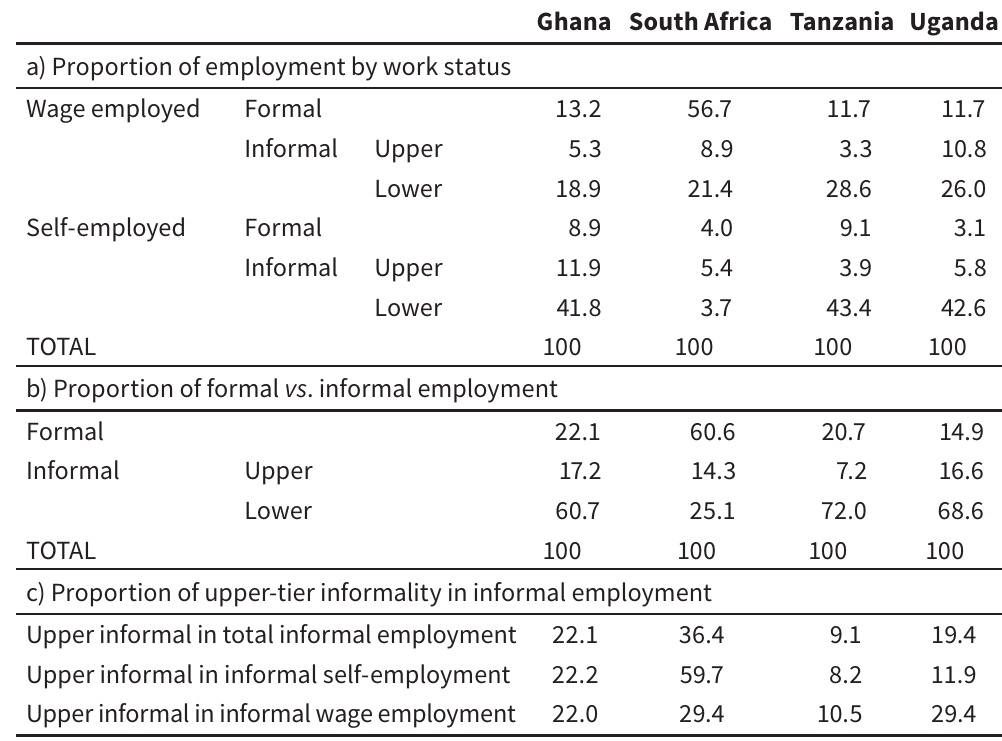
Distribution of workers by work status (%) Ghana South Africa Tanzania